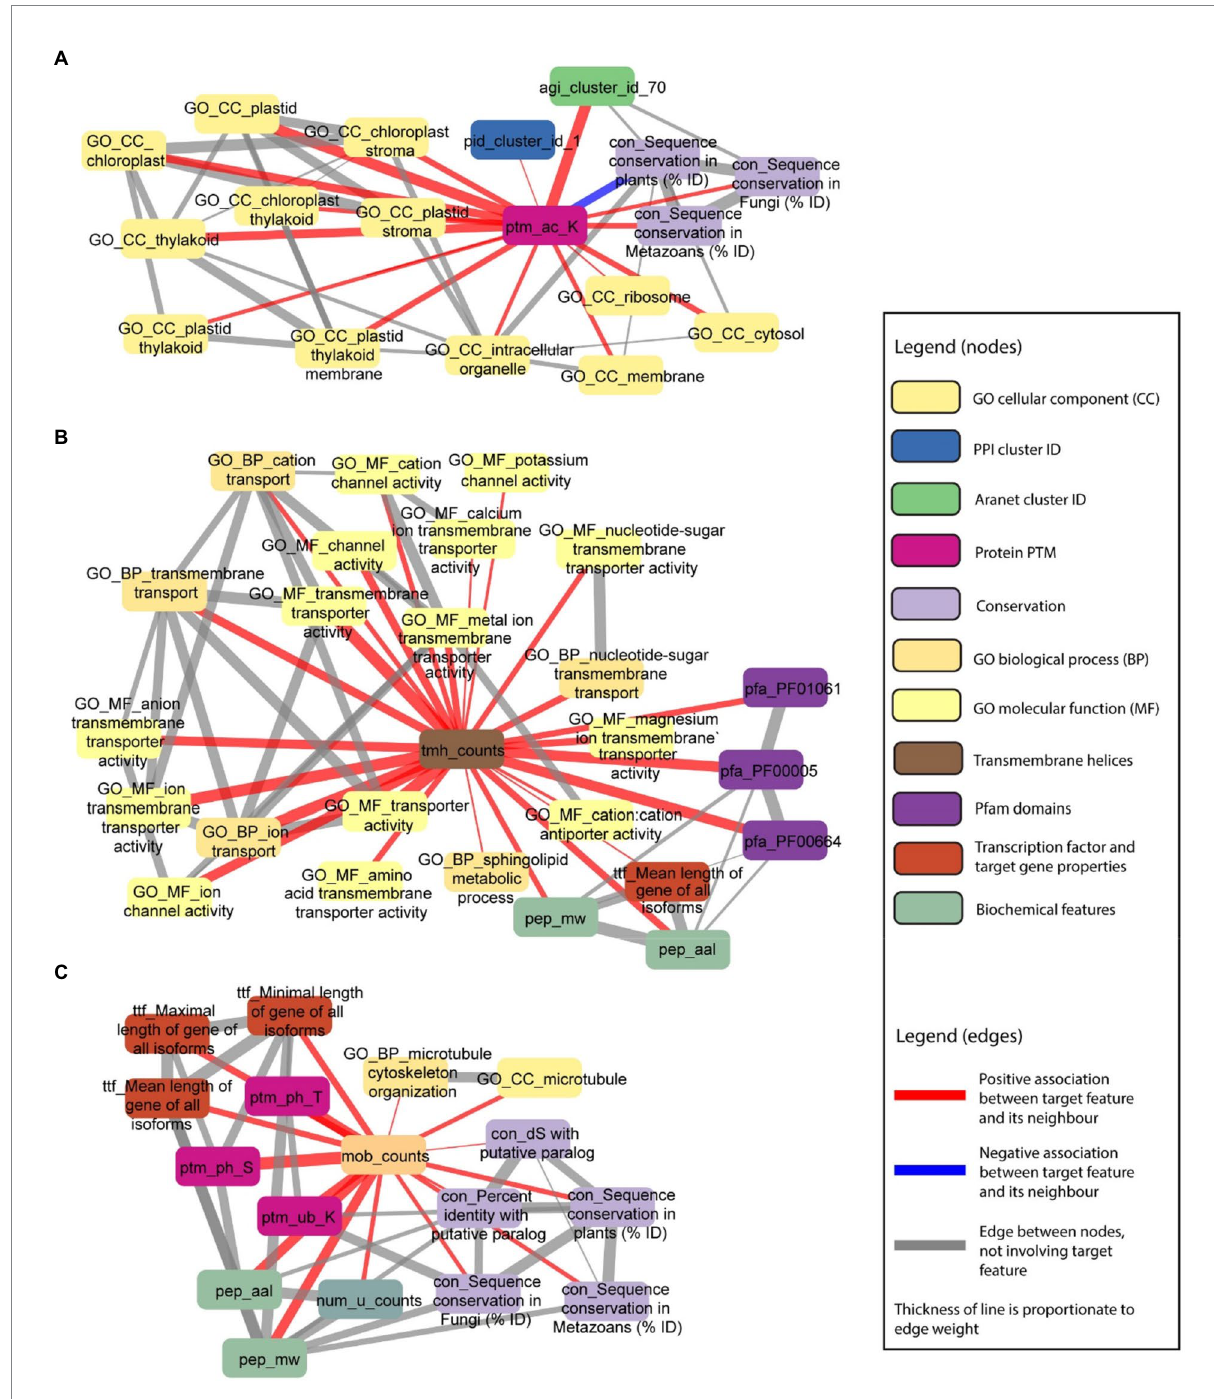
FIGURE 8 Examples capturing posttranslational modifications and the number of transmembrane and disordered domains. Selected nodes and edges from the local neighbourhood of specific features in the database are shown. (A) Protein PTM—lysine acetylation (ptm_ac_K) is positively associated with GO cellular components terms (nodes starting with “GO_CC_”), especially those related to the chloroplast. (B) Number of transmembrane helices in a protein sequence (tmh_counts) is positively associated with GO transmembrane transporter and channel terms (nodes starting with “GO_”), and sphingolipid metabolic process (GO_BP_sphingolipid metabolic process). (C) Number of disordered domains in a protein sequence (mob_counts) is positively associated with sequence conservation in paralogs, plants, fungi and metazoans (nodes starting with “con_”), GO microtubule terms (nodes starting with “GO_”), gene length (nodes starting with “ttf_”), protein PTMs (nodes starting with “ptm_”), protein length (pep_aal), number of unique protein domains (num_u_counts), and protein molecular weight